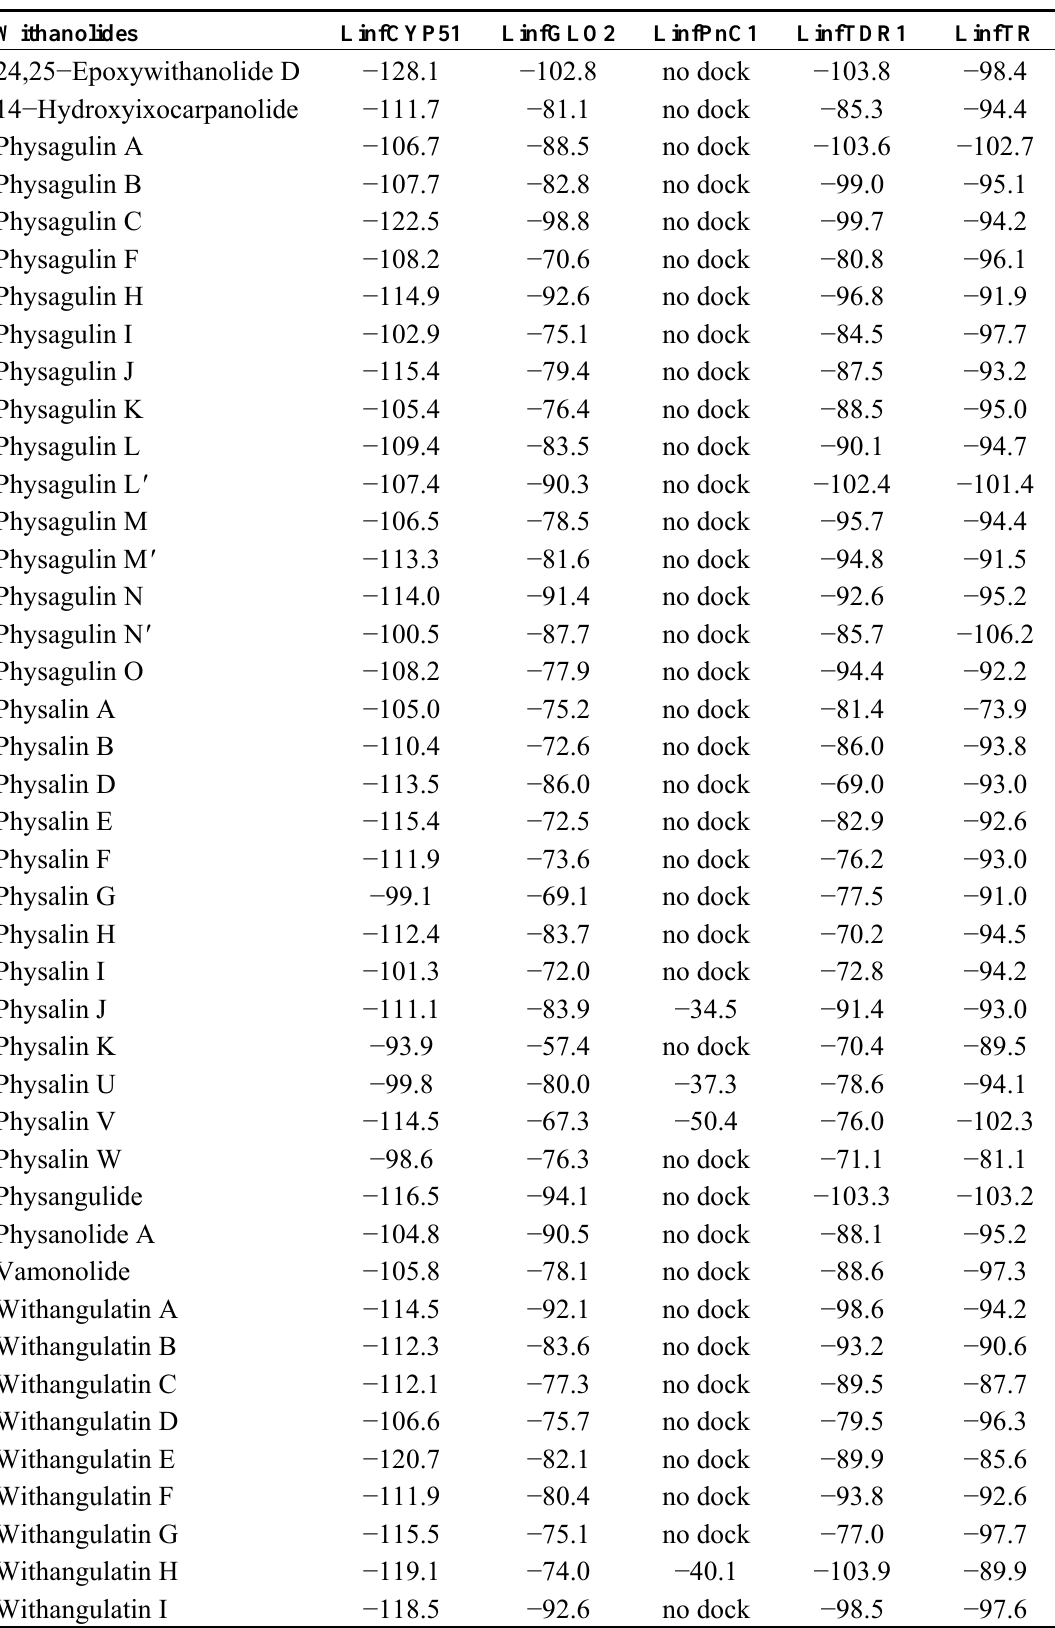
Table 34. MolDock docking energies (kJ/mol) of withanolides with Leishmania infantum protein